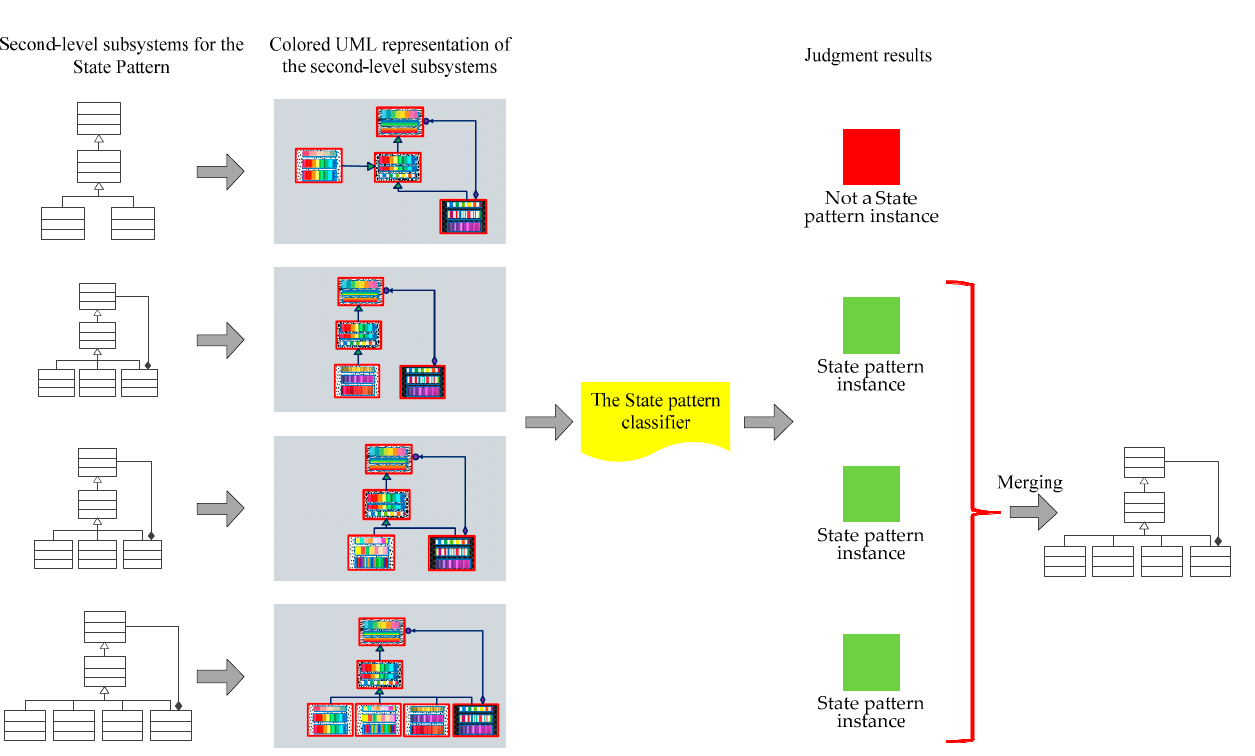
Figure 9. Schematic diagram of the judgment and merging of the four second-level subsystems for the State Pattern.